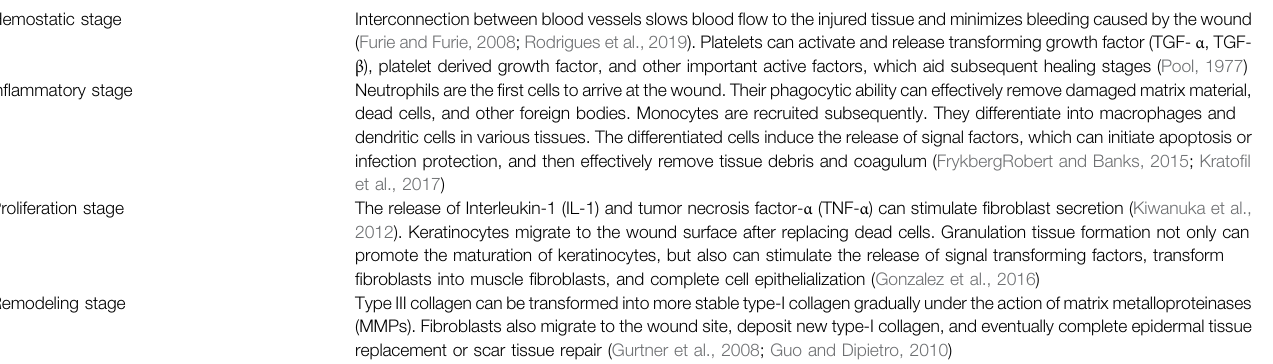
TABLE 1 | The four stages of wound healing and their characteristics. Hemostatic stage Interconnection between blood vessels slows blood fl ow to the injured tissue and minimizes bleeding caused by the wound (Furie and Furie, 2008; Rodrigues et al., 2019). Platelets can activate and release transforming growth factor (TGF- α , TGF- β ), platelet derived growth factor, and other important active factors, which aid subsequent healing stages (Pool, 1977) In fl ammatory